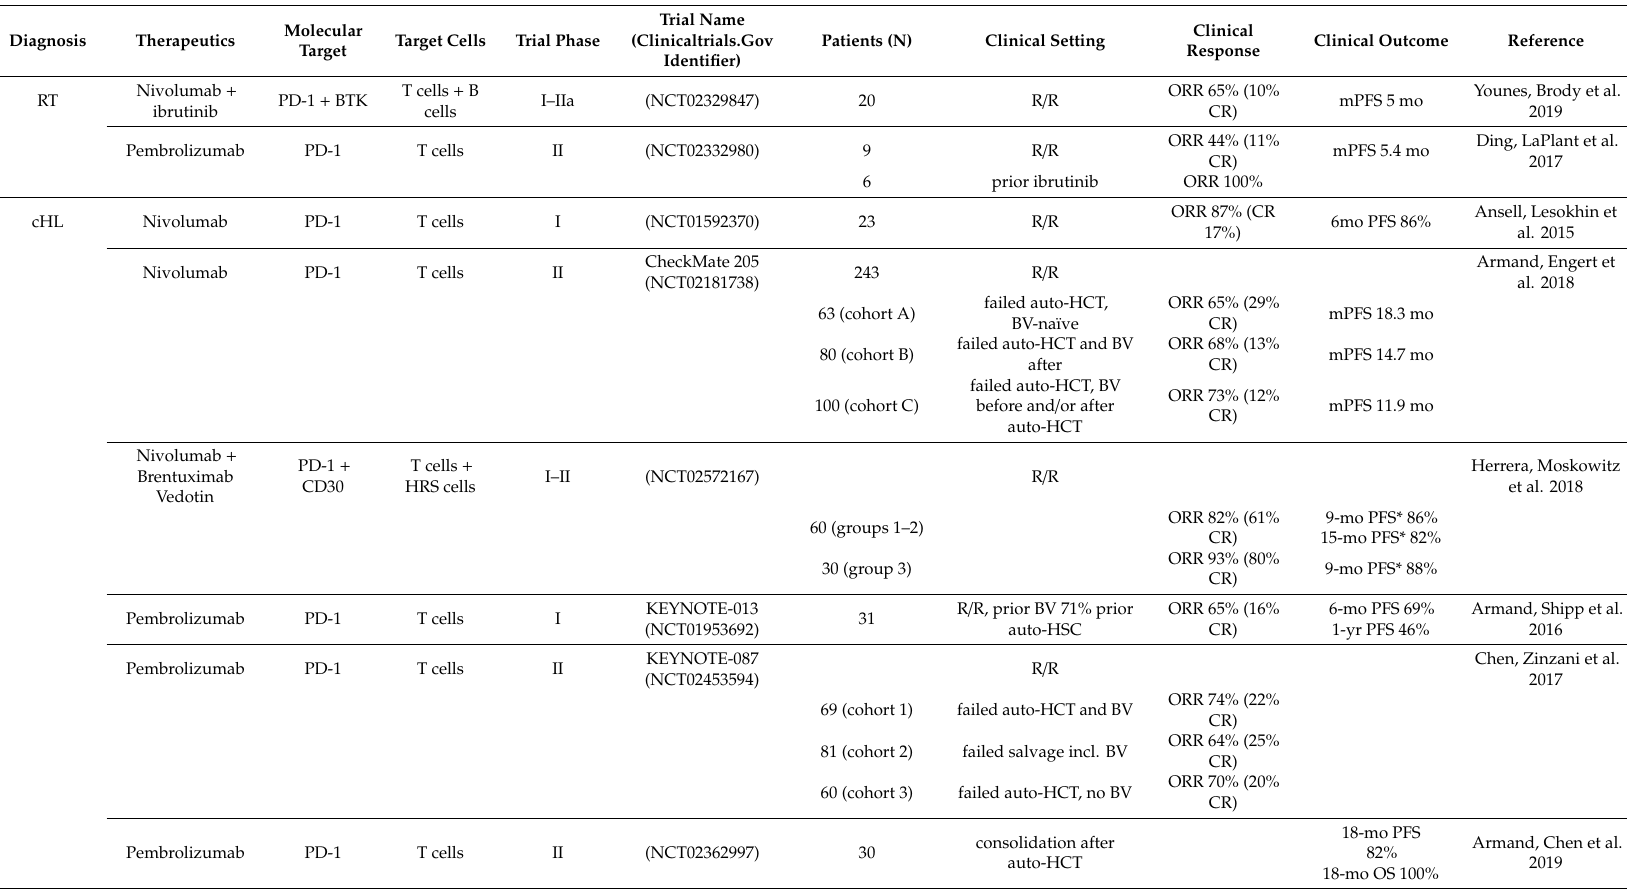
Table 3. Published clinical trials with therapeutics targeting the immune tumor